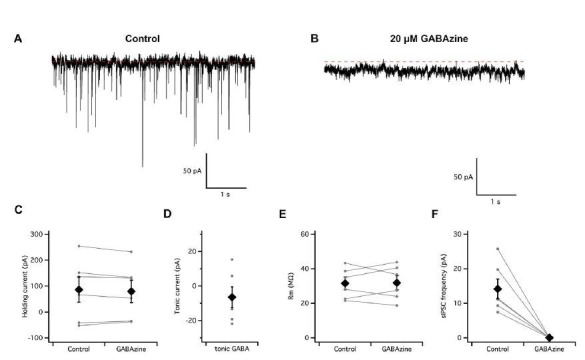
Absence of a tonic GABA-A receptor mediated input to entorhinal cortex stellate cells.(A–B) Continuous voltage-clamp recording of spontaneous synaptic activity from a stellate cell in control conditions (A) and during perfusion of GABAzine to block GABA-A receptors (B). (C–D) Perfusion of GABAzine did not affect the holding current (C–D) or input resistance (E) but abolished fast spontaneous inhibitory currents (F).